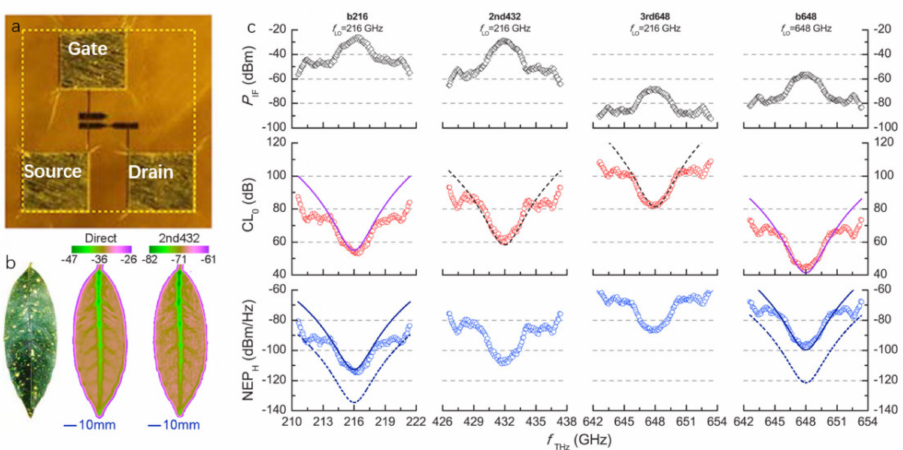
Figure 8. ( a ) The optical microscope image of the detector. ( b ) The photographs of the direct detection and second harmonic detection of fresh blades at 432 GHz, respectively. ( c ) The experimental results at different frequencies. The top, middle, and bottom represent the incident power, mixing loss, and noise power, respectively. Reprinted with permission from ref. [101]. Copyright 2021 Copyright Clearance